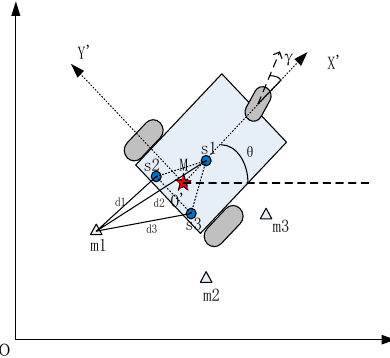
Figure 7. Observation model of the mobile robot. The blue dots marked numbers s1–s3 are the sound sources. The red pentagram marked M is the reference microphone and the white triangles marked numbers m1–m3 are the MTPs.